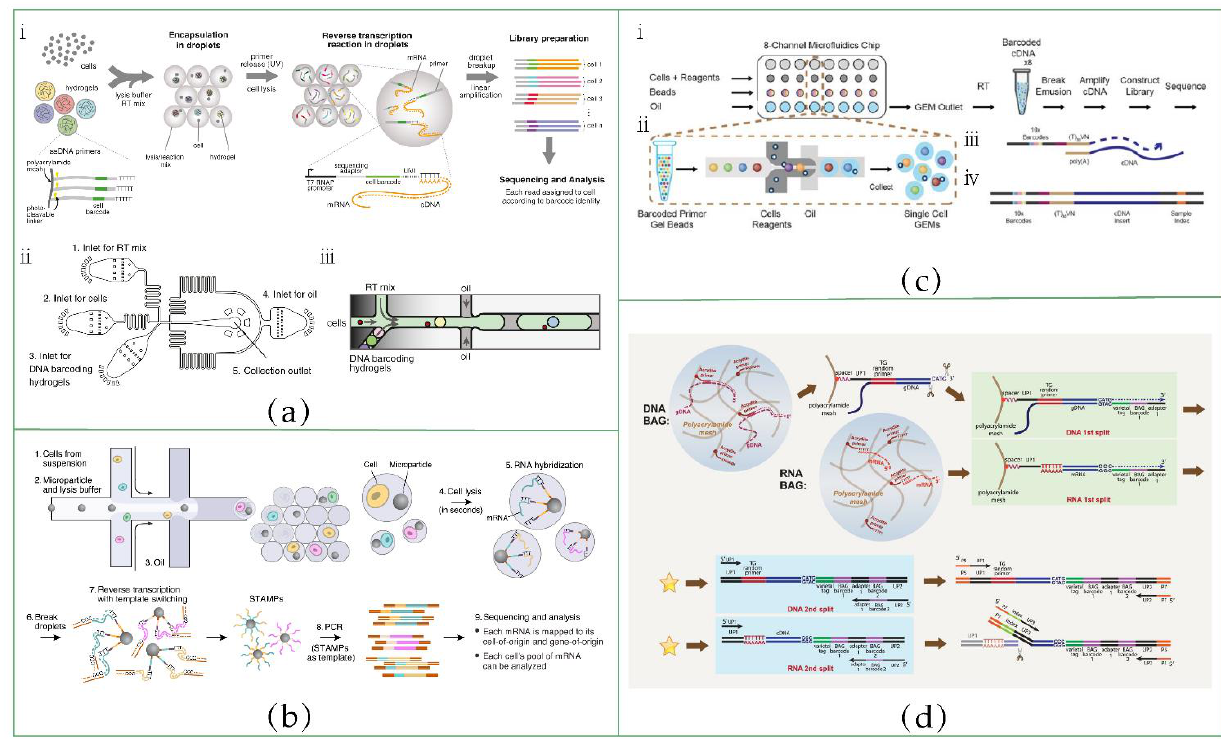
Figure 4. Application of droplet microfluidics in scRNA-seq: ( a ) i, inDrop RNA sequencing workflow; ii, design of the microfluidic device for co-encapsulation of cells and BHM; iii, schematic diagram of the process of co-encapsulation of cells and BHM. Reprinted from ref. [66]. ( b ) Schematic of sequencing library preparation with Drop-Seq. Reprinted from ref. [33]. ( c ) i, scRNA-seq workflow on 10x genomics platform; ii, cells and gel beads are co-encapsulated in microfluidic chip; iii, barcoded primer annealing with RNA; iv, finished library molecule. Reprinted from ref. [67]. ( d ) BAG-seq workflow. Reprinted from ref. [85].